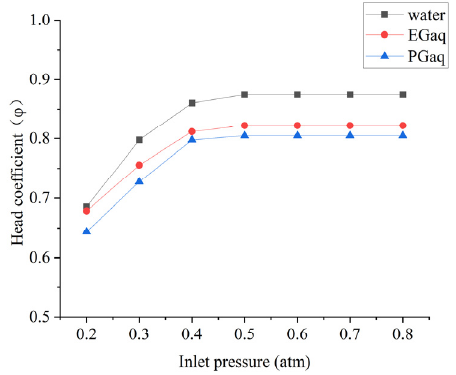
Figure 14. Cavitation curve of the pump with cylindrical blades at 20 °C.